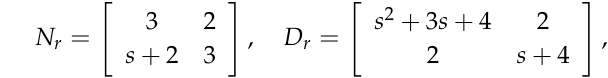
Table 2. Relative norm of TV 2 , relative norm of TX , norm of V T